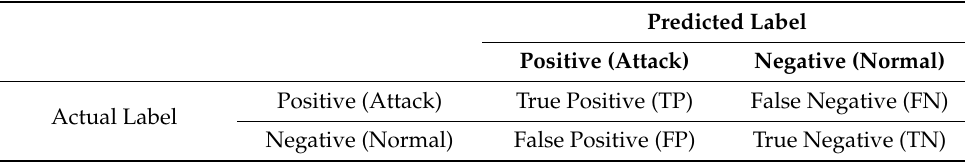
Table 2. Confusion matrix for binary classification